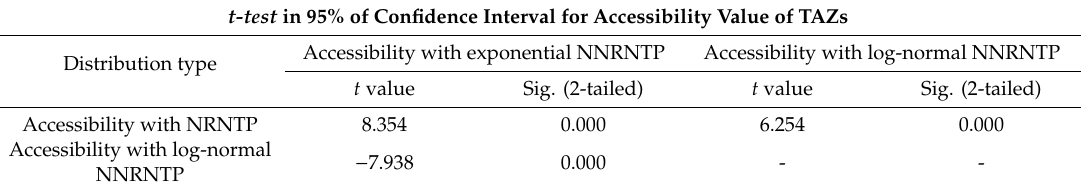
Table 5. t -test for analyzing the di ff erence between the accessibility of TAZs generated by the models. t-test in 95% of Confidence Interval for Accessibility Value of TAZs